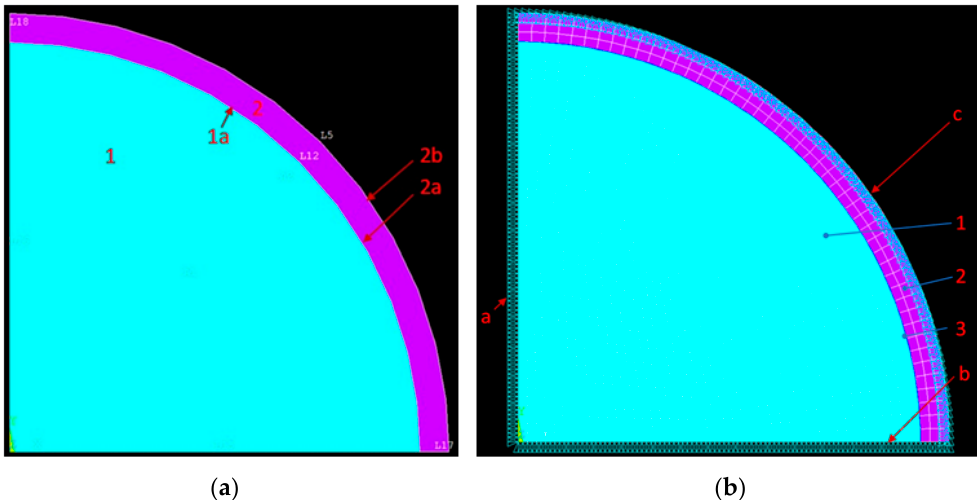
Figure 10. ( a ) Model of contact between ball joint pin 1 and its bearing 2; ( b ) the mesh of finite elements and boundary conditions.